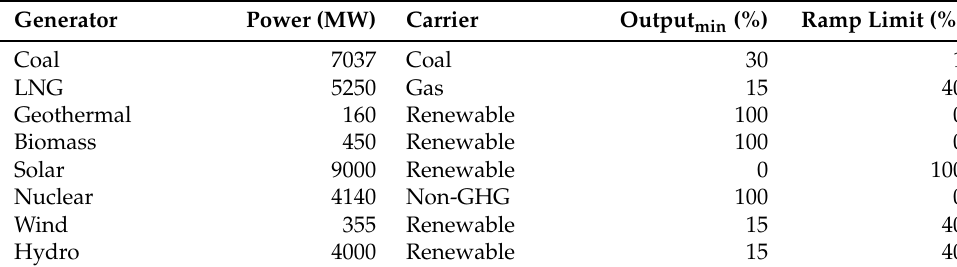
Table 5. Generators in Kyushu as of FY2019.